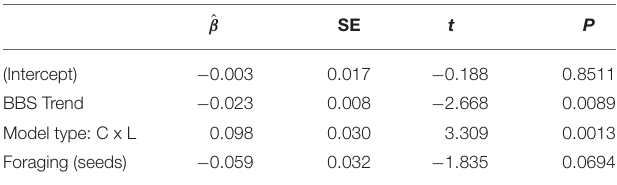
TABLE 1 | Parameter estimates from phylogenetically independent contrasts (PIC) for the influence of life history and ecological traits on the capacity of models to predict bird abundance changes ( ρ1 ).